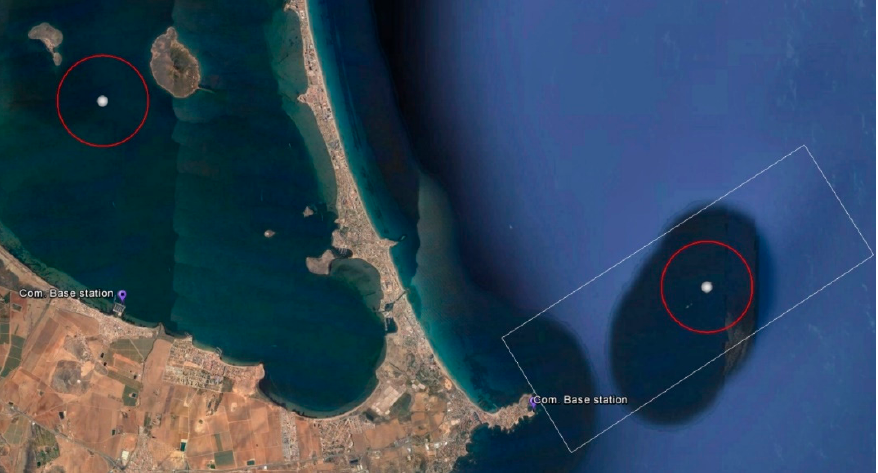
Figure 14. Scale experiment. Equivalence of area and distance from integral reserve (Islas Hormigas) to base station (right) and equivalent area in Mar Menor (left).